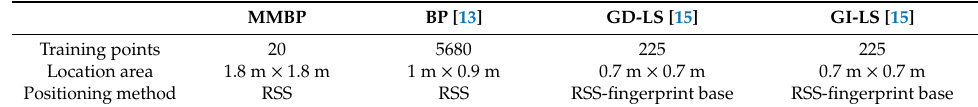
Table 6. Parameters of di ff erent location